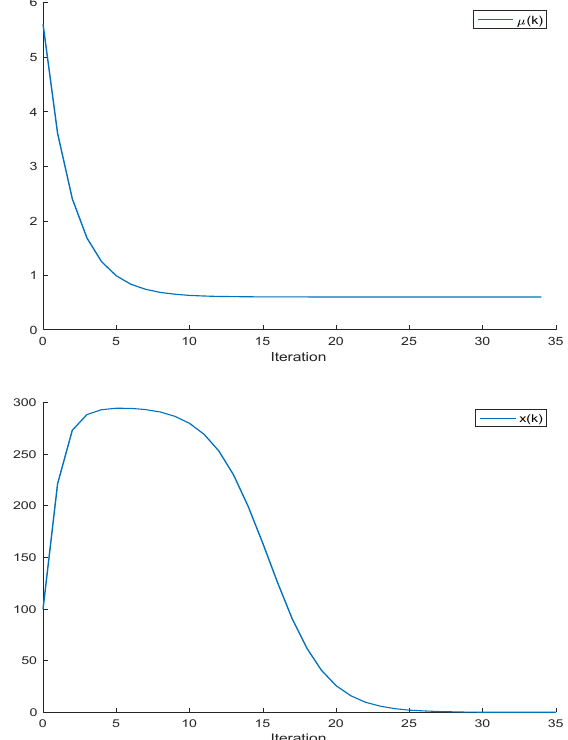
Figure 1. Evolution of µ ( k ) and x ( k ) with iteration in Example 2 when µ ( k ) converges to a limit below unity.